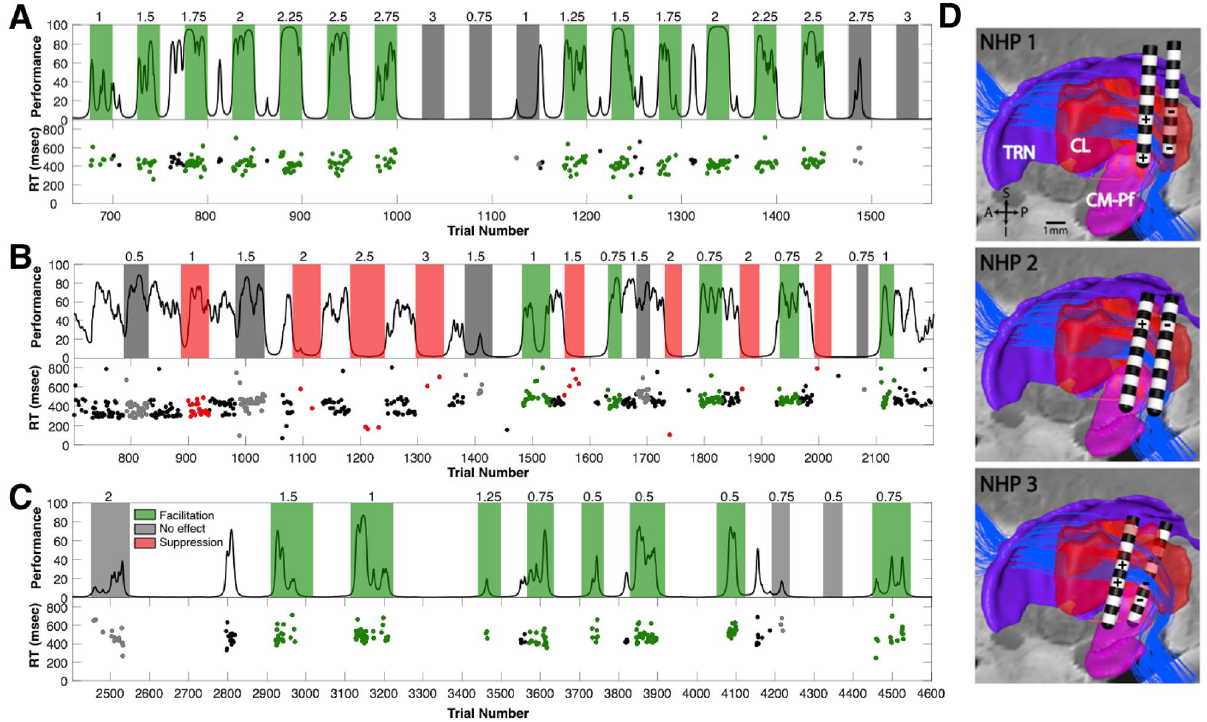
Figure 3. The effects of CT-DBS amplitude on behavioral performance across animals. ( A ) The performance estimate of NHP1 on the visuomotor reaction time task is shown in the upper plot as a smoothly varying black line and thalamic boundaries 51 shown on the left. Periods of continuous high-frequency CT-DBS are colored according to the significance of the LOR value ( p < 0.05); facilitation in green, suppression in red, and gray for no effect. Stimulation amplitudes (0.75–3.0 mA) are noted above each CT-DBS period and the same anode– cathode configuration was used. The lower plot shows the reaction times of correctly performed trials with the same color code; reaction times are in black for CT-DBS OFF periods. (B) Same as in A, but for NHP2 ( partial reproduction of Fig. 2C,D in Baker et. al., 2016 ). In this session, CT-DBS stimulation amplitudes greater than 1.5 mA significantly suppressed performance whereas amplitudes 1.5 mA and below had either no effect or modestly facilitated performance. The same anode–cathode configuration was used throughout. (C) Same as in A and B, but for NHP3. This animal performed a variation of the vigilance task that required more engagement with the task (see “Methods” section); hence, the great number of trials. (D) Reconstruction of the lead locations for each NHP shown in the sagittal plane, along with the CL, CM and TRN nuclei and the fibers of the DTTm are shown in blue. The anode (+) and cathode (−) field-shaping configurations are shown for